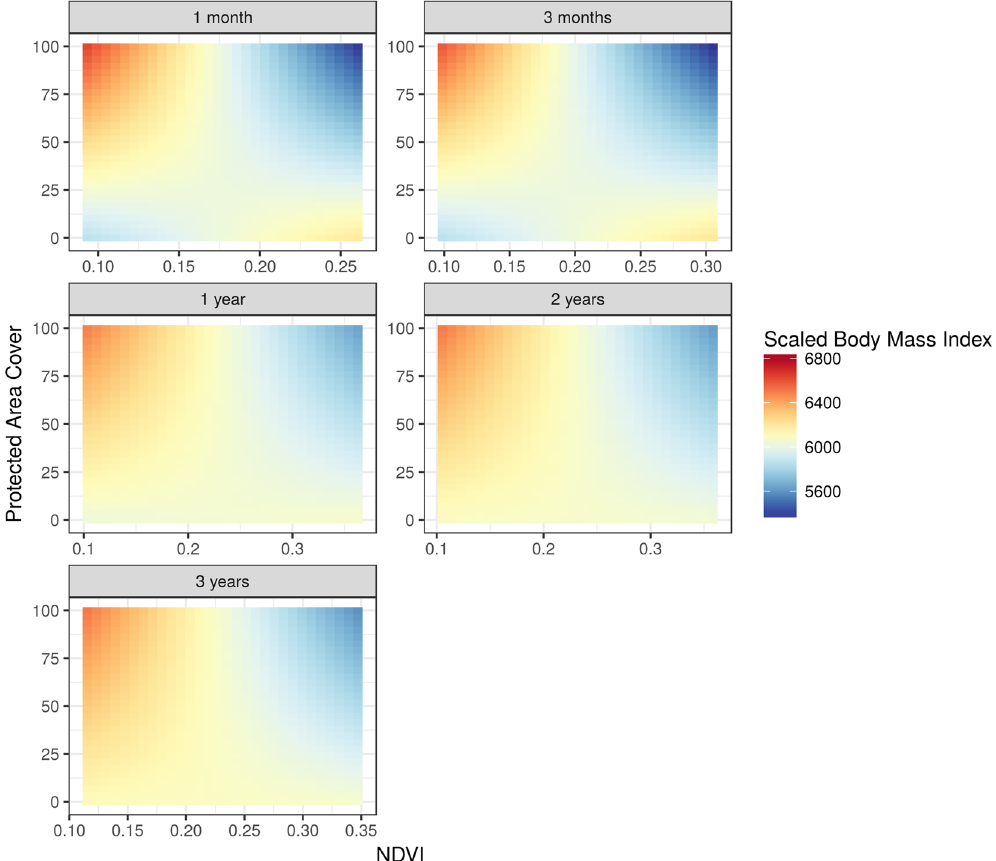
Figure 3. Predicted body condition (here in the form of the scaled body mass index) of lappet-faced vulture nestlings in relation to the normalized difference vegetation index (NDVI) and the cover of protected areas around the nest. The different panels show results obtained by using NDVI calculated at five temporal scales - representing the situation during the one month prior to the measurement and up until 3 years prior to the measurement. These predictions are derived from the model including the interaction term between protected area cover and each of the five NDVI measures (see methods for further details). Warm colors indicate better condition compared to cold